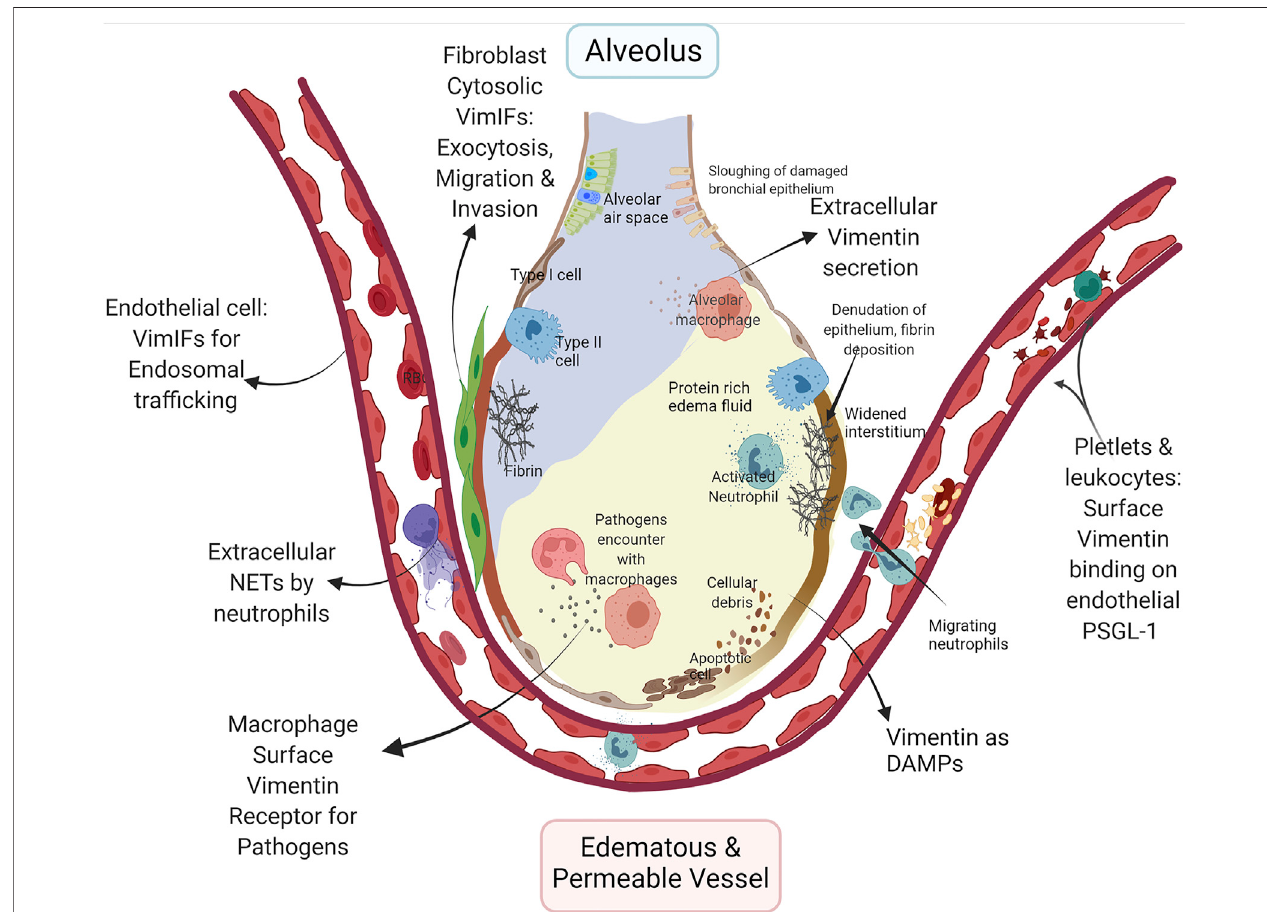
FIGURE1| Multifacetedroleofvimentin inARDS/ALI:Increasedpermeabilityofthealveolar-capillarymembrane andpro-in fl ammatoryconditionsarefundamental characteristicsofALI.Theschematicdemonstrateveryfewepithelialcellsduetoincreasedcelldeath,andtheintra-alveolarspacedepictedrepresentsthealveolarlining fl uidthatisincontactwiththeair.Theincreasedexpressionofsurfacevimentinonendothelialcellsenhanceslymphocyteadhesionandtransmigrationacrossendothelial cells through PSGL-1 binding on the lymphocytes, including neutrophils. Expression of vimentin and dynamics of Vimentin intermediate fi laments regulate the endosomalsignalingthroughRabGTPasetotransportVE-cadherintothecellsurfaceinendothelialcellsforthemaintenanceofbarrierfunctions.ThePTMonvimentinin neutrophils leads to neutrophil extracellular traps (NETs) via netosis. NETs disrupt the microvascular endothelial barrier, increasing edematous and permeable vessels and causing a protein-rich fl uid in fl ux in the airspace. The increased expression of vimentin on platelets increases vitronectin and PAI-1 complex formation, which may provide stabilization of thrombi. The fi brins and fi brinolysis-related enzymes cause the dissolution of epithelial surface proteins and denudation of the epithelial barrier layer. Vimentin expression in fi broblasts regulates exocytosis and invasion, contributing to their proliferation in ALI. The surface vimentin on macrophage is essential for several bacteria and viruses for the host cell invasion and phagocytosis. Secreted vimentin from dead cell debris and activated immune cells act as DAMPs. The fi gure was created with BioRender.com.